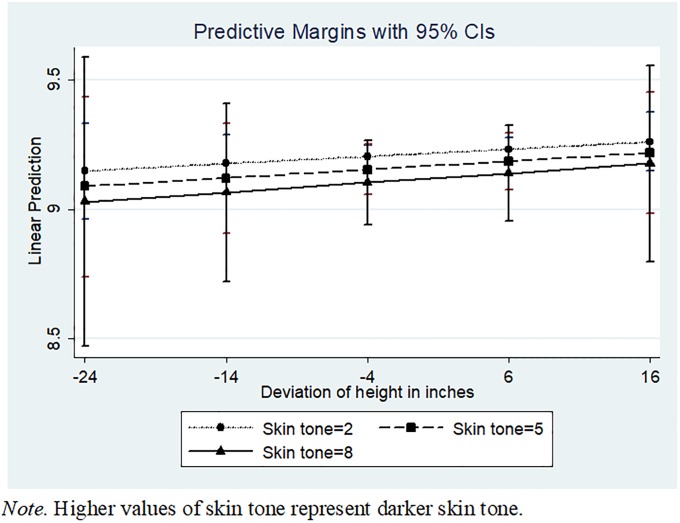
Three-way interaction between skin tone, height, and gender.Graphed lines indicate impact of skin tone and height on earnings for women.